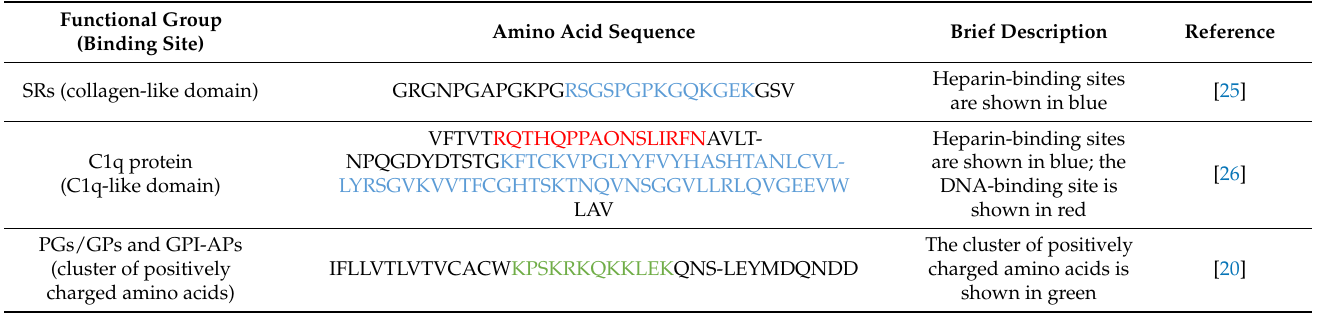
Table 1. Amino acid sequences of three specific polyanion/heparin/dsDNA-binding sites used as a reference for database